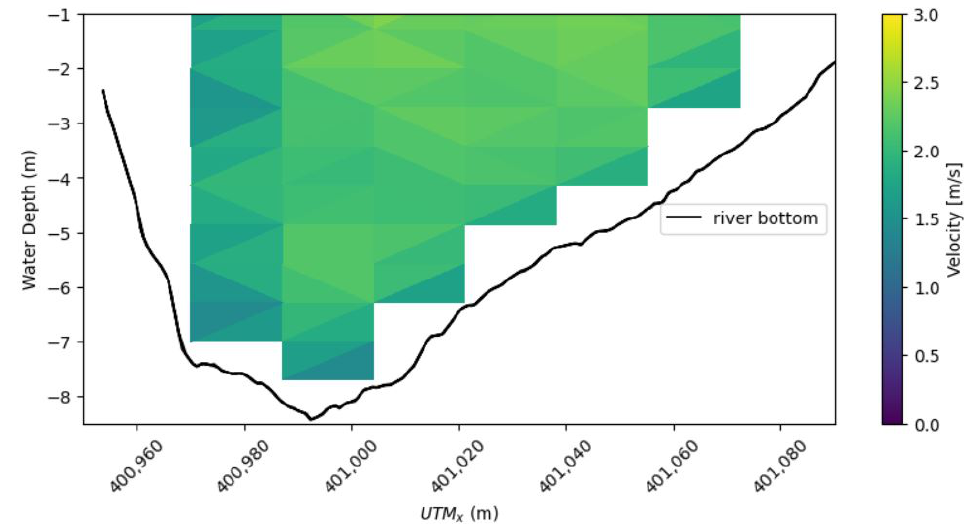
Figure 6. Down-sampled velocity magnitude from Figure 5. ADCP data was down-sampled to match the discretization of the Delft3D model.